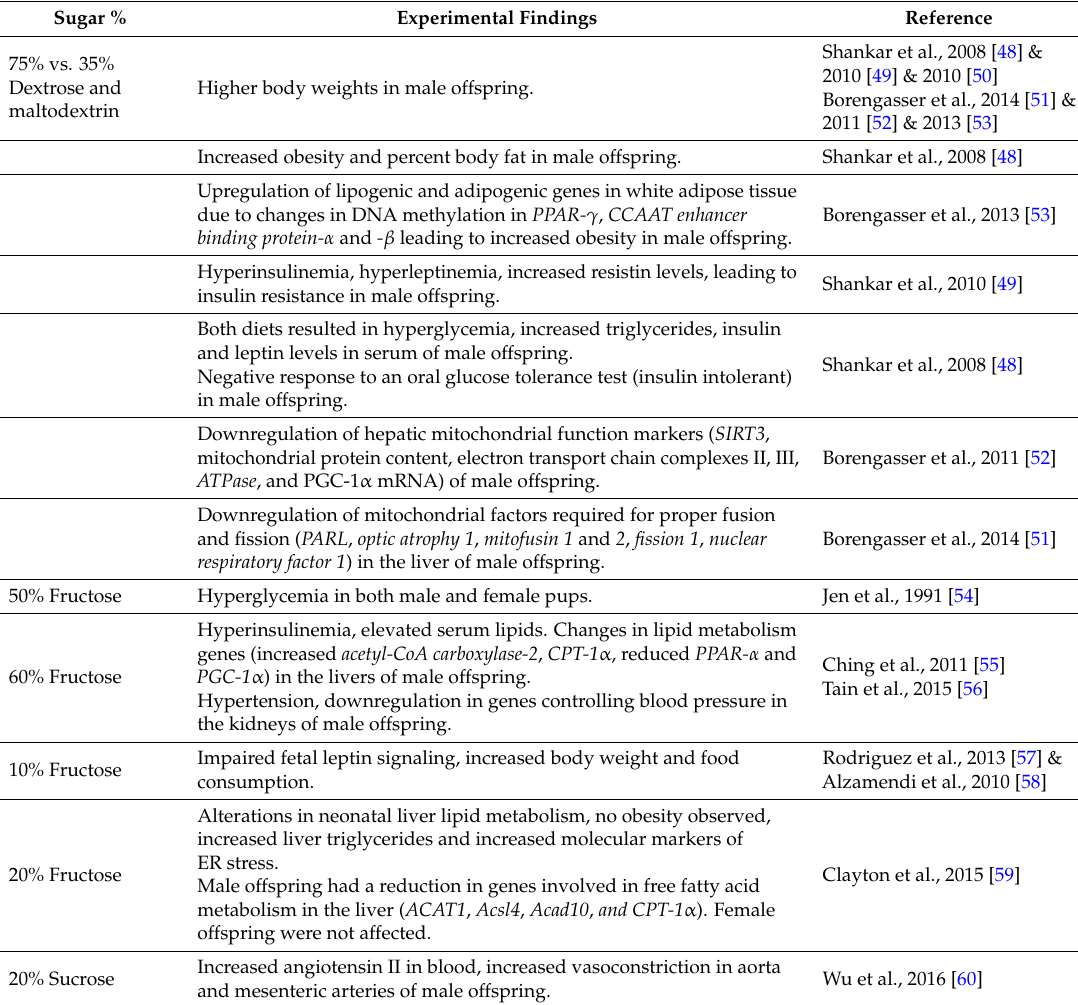
Table 2. Summary of evidence for long-term influences of maternal high-sugar diets on offspring health